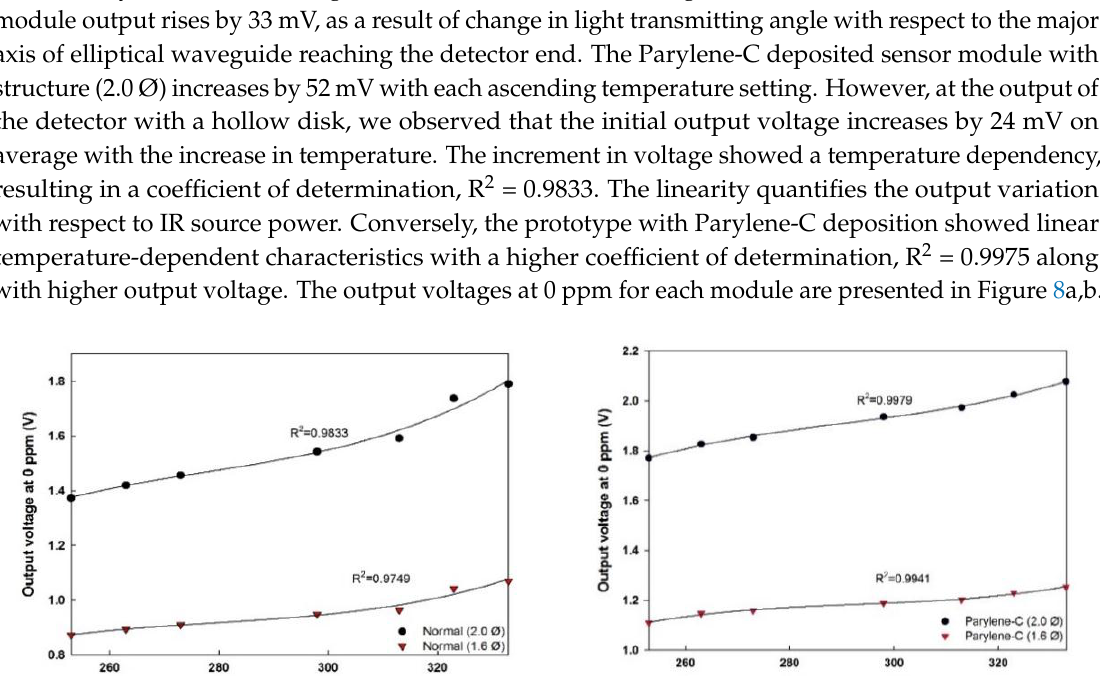
Figure 7. ( a ) On-off time of the IR source and response of the sensor; ( b ) response time of the sensor.